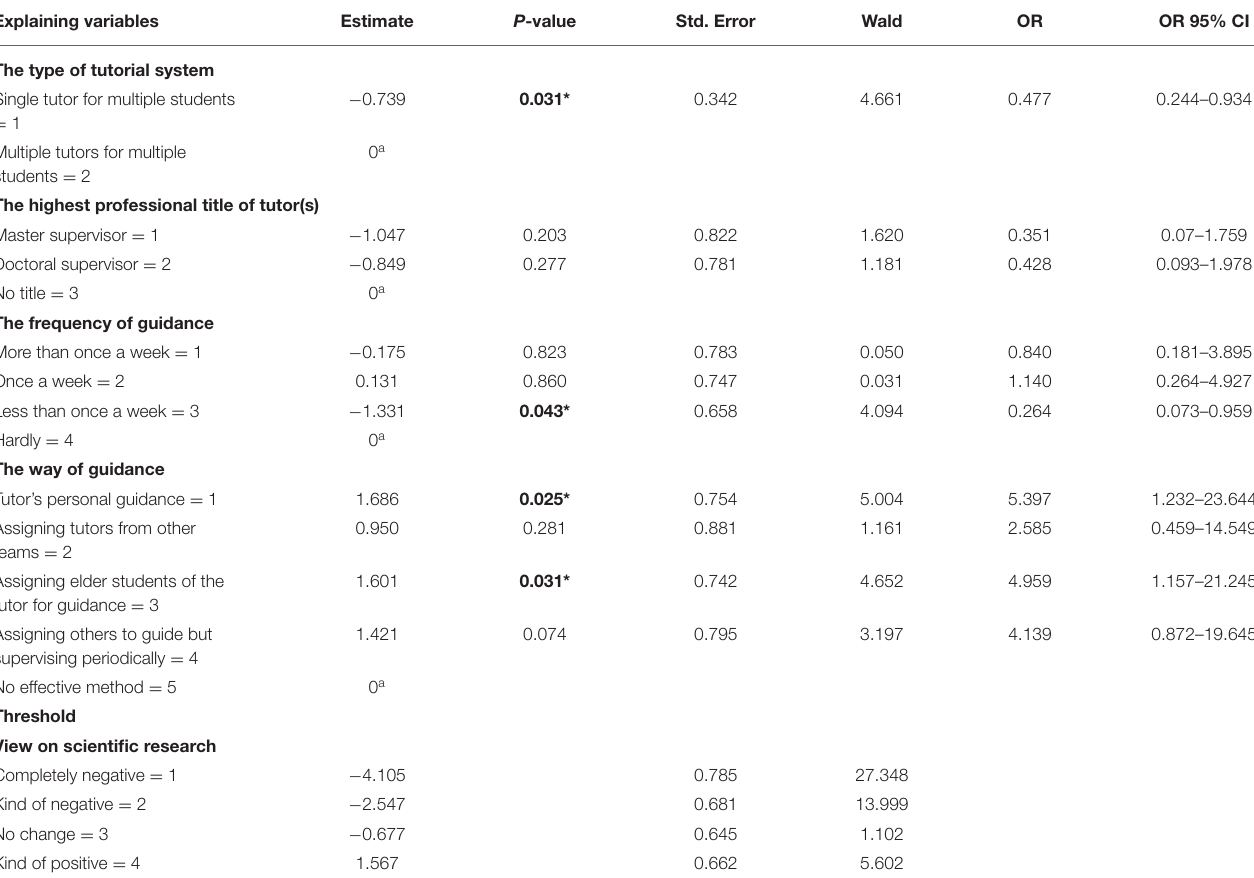
TABLE 3 | Multiple ordinal logistic regression analysis of influential factors of view on scientific research after the guidance of the